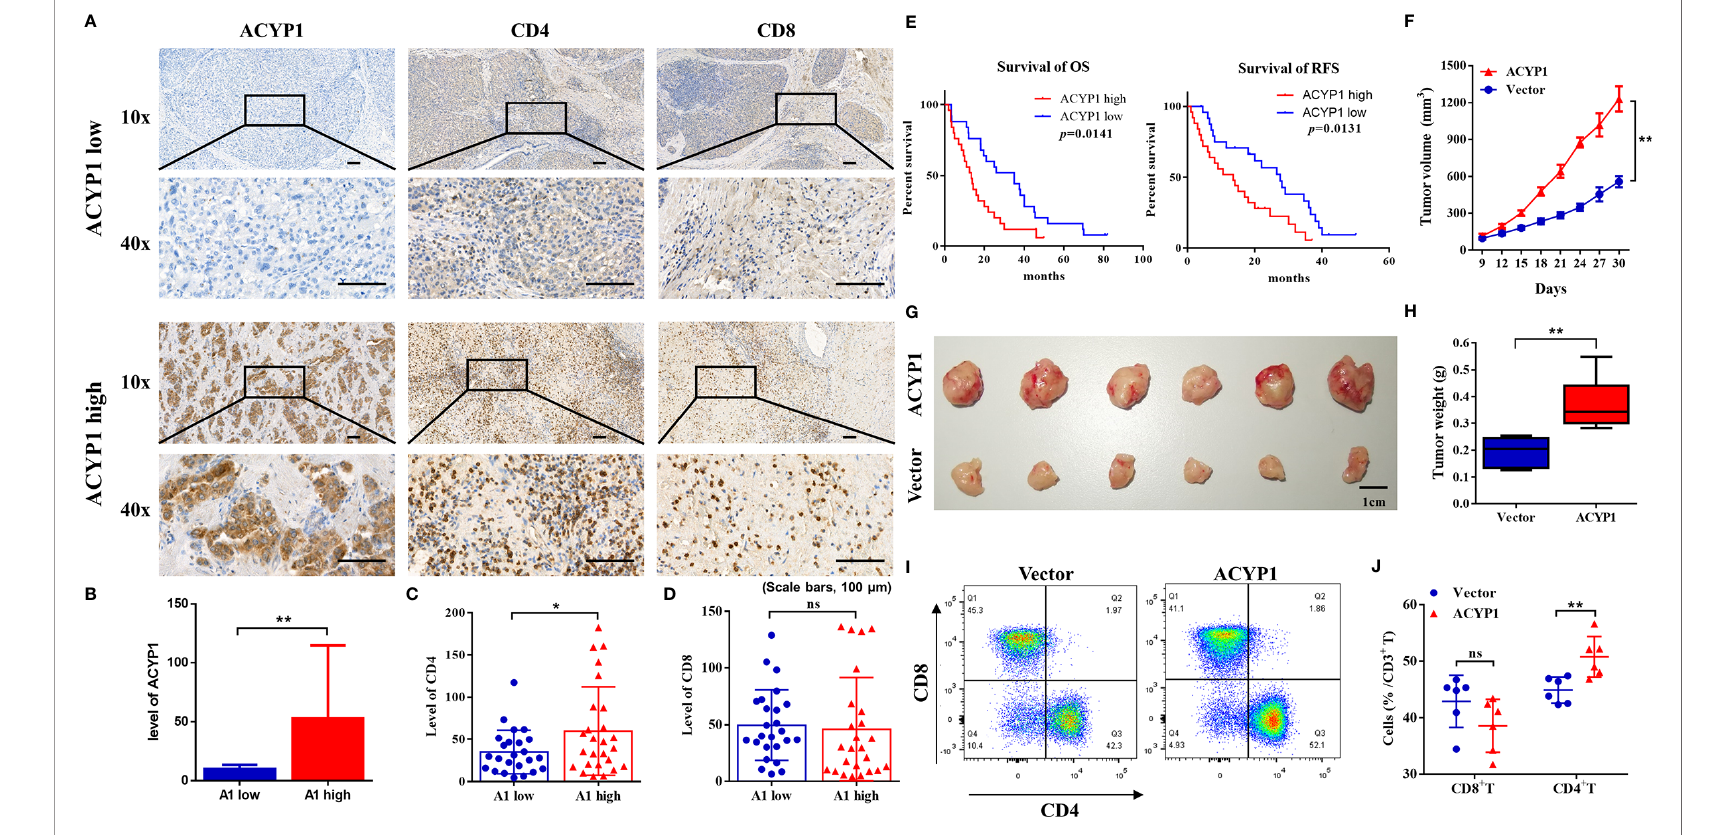
FIGURE 6 | Preliminary experimental veri fi cation of the ACYP1 signature in LIHC. (A) Representative samples with low and high ACYP1 expression for IHC staining of ACYP1, CD4+ and CD8+ T cells in the ACYP1 low and high group were taken at 100x and 400x magni fi cation. (B – D) Relative quantitative analysis of ACYP1 (B) , CD4 (C) and CD8 (D) levels by IHC staining. (E) Survival analysis of the ACYP1 high group and the ACYP1 low group in 50 LIHC patients. (F) Subcutaneous growth of Hep1-6 tumors in the vector group and ACYP1 overexpression group (n=6). (G) Representative images of subcutaneous Hep1-6 tumors in the vector group and ACYP1 overexpression group (n=6). (H) The weight of subcutaneous Hep1-6 tumors in vector group and ACYP1 overexpression group (n=6). (I, J) The relative content of CD4+ T cells and CD8+ T cells in subcutaneous Hep1-6 tumors from vector mice and ACYP1 overexpressing mice (n=6). Positive cell percentages are shown. *P < 0.05, **P < 0.01, n.s. "no signi fi